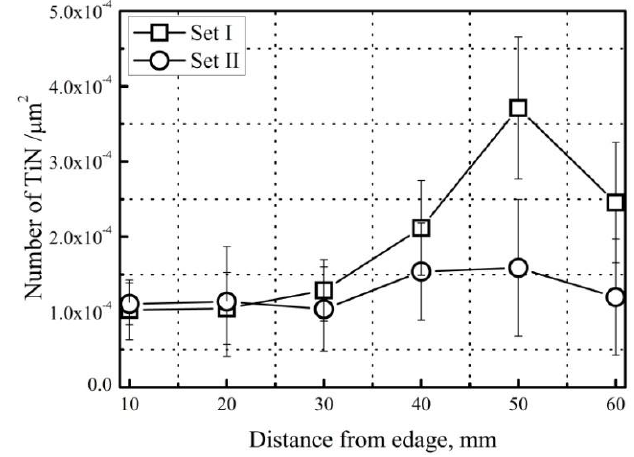
Figure 8. Variations of the TiN inclusion number along the radius direction of Incoloy800H superalloy billet in Set I and II.